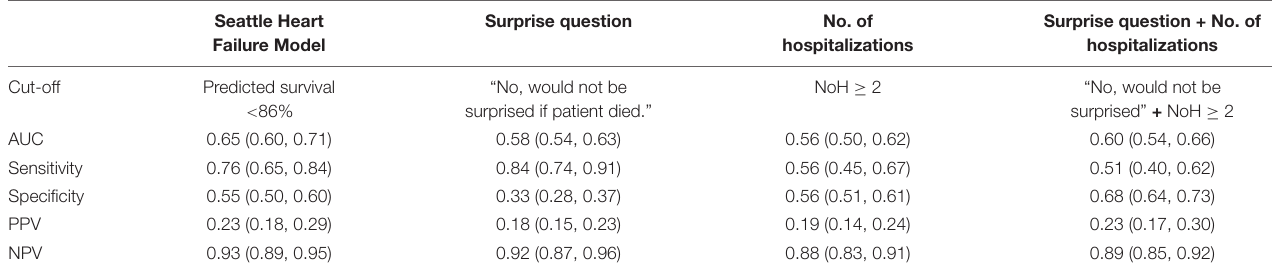
TABLE 2 | Discrimination of the Seattle Heart Failure Model, the surprise question, the number of hospitalizations and a combination of the latter for prediction of 1-year survival. Seattle Heart Surprise Failure Model